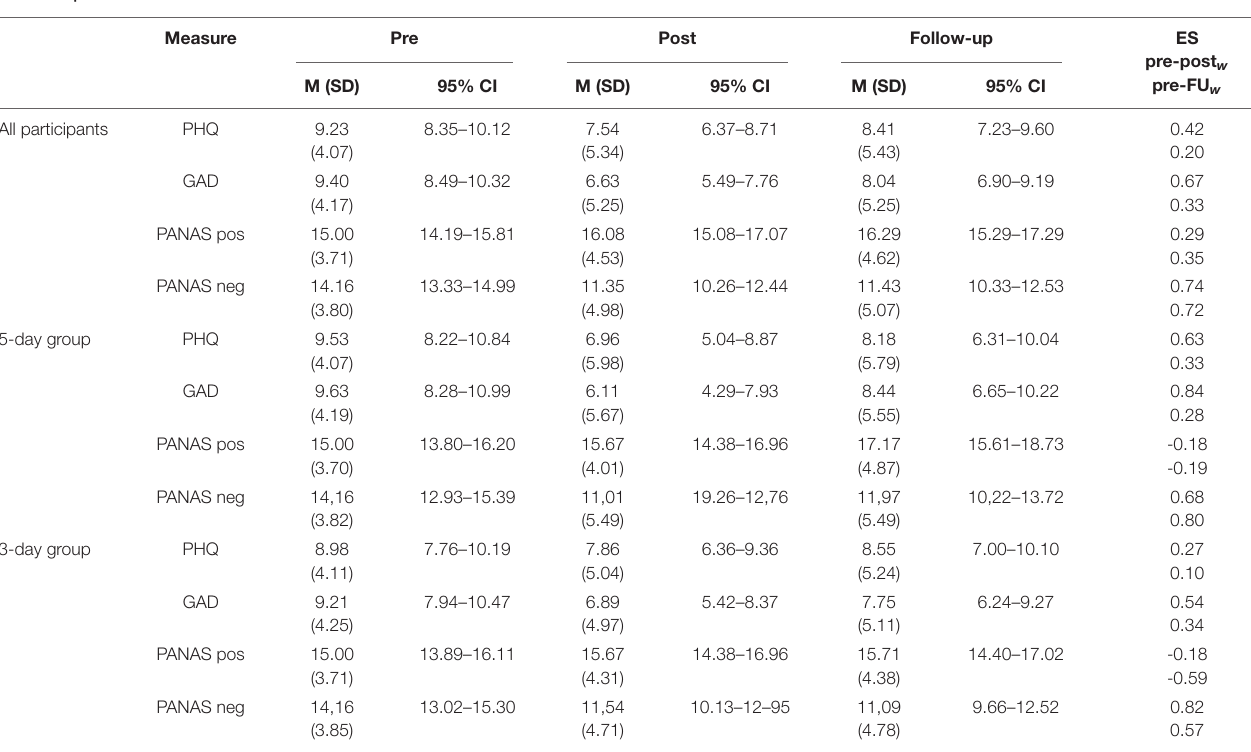
TABLE 6 | Estimated means values and effect